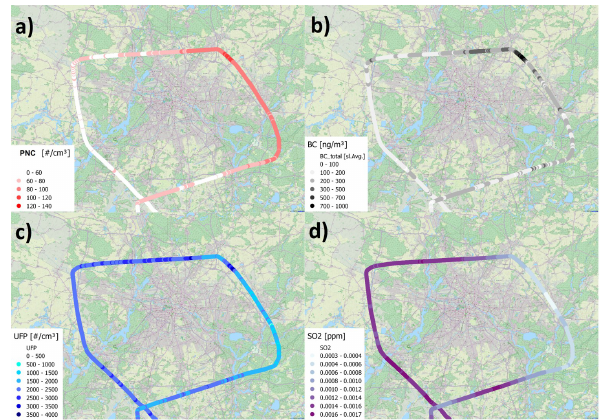
Figure 4. Spatial distribution of the air plane measurements on 10 October 2014: (a) coarse particle number concentration, (b) BC, (c) ultrafine particle number concentration and (d) sulfur